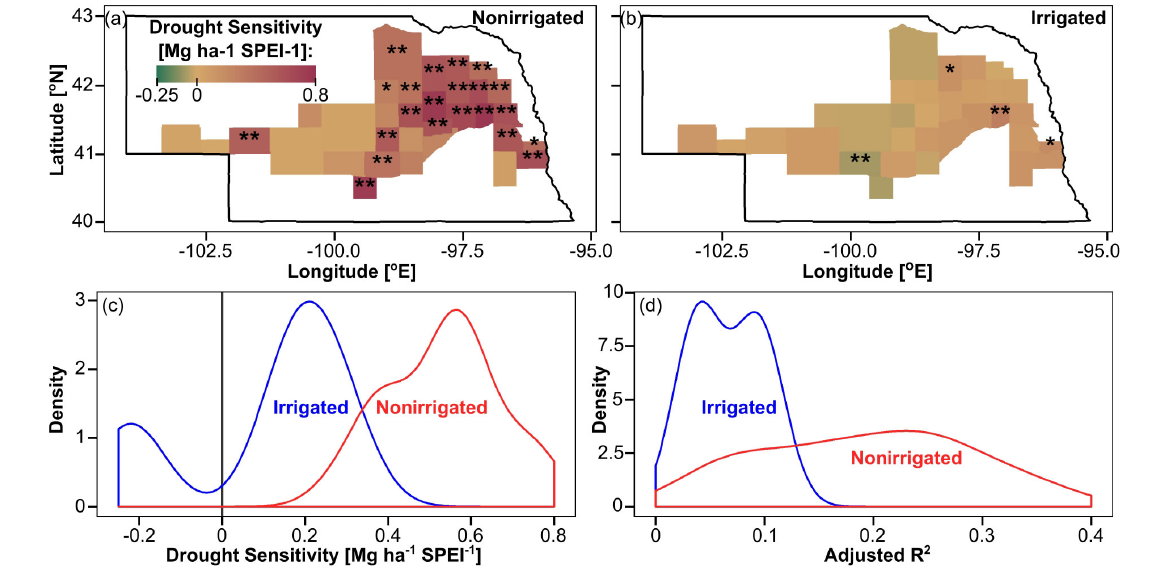
Fig. 2 . (a, b) Slope of the Yield-SPEI (Standardized Precipitation Evapotranspiration Index) relationship for each county within the Platte River Watershed. Scale bar in (a) applies to both (a) and (b). Because a negative SPEI corresponds to more severe drought, a positive slope indicates yield losses in response to drought. ** p